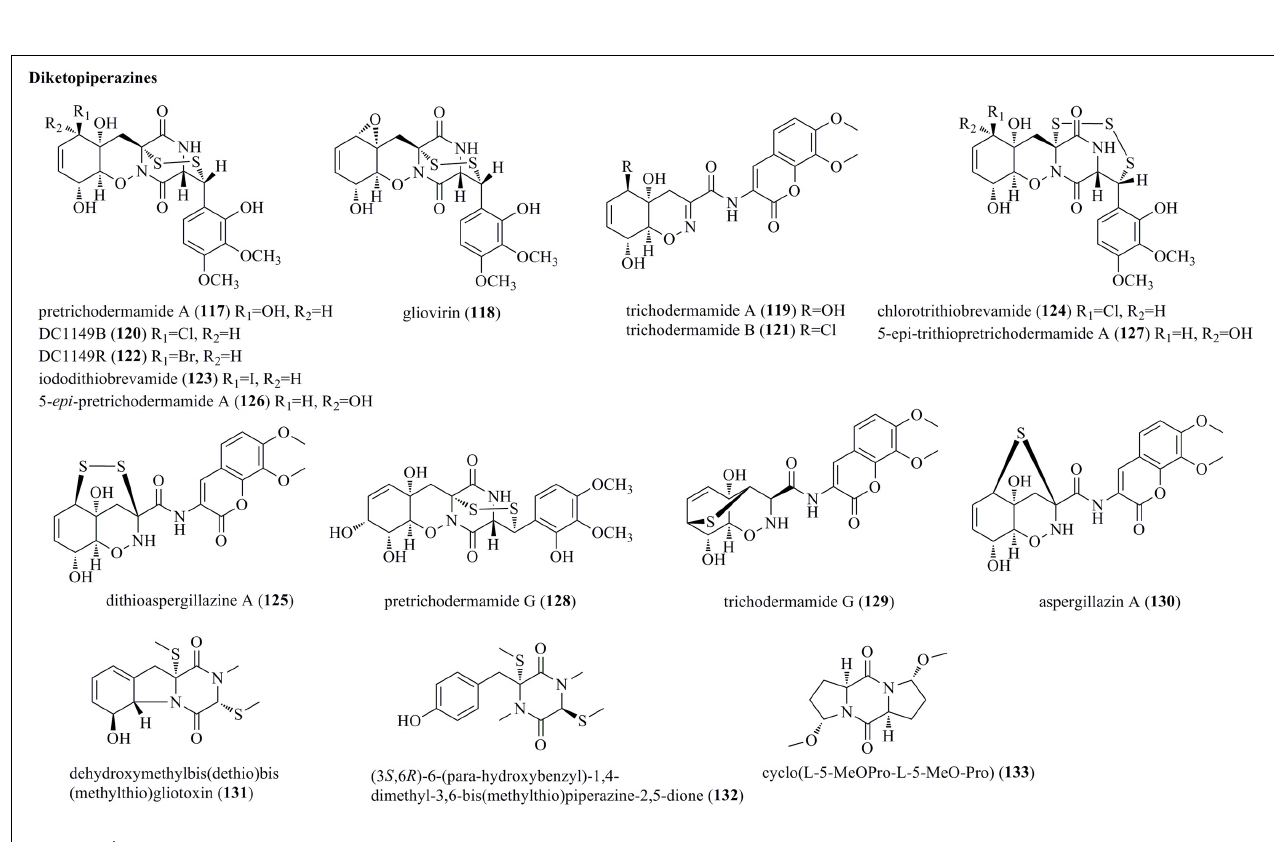
Frontiers in Microbiology |